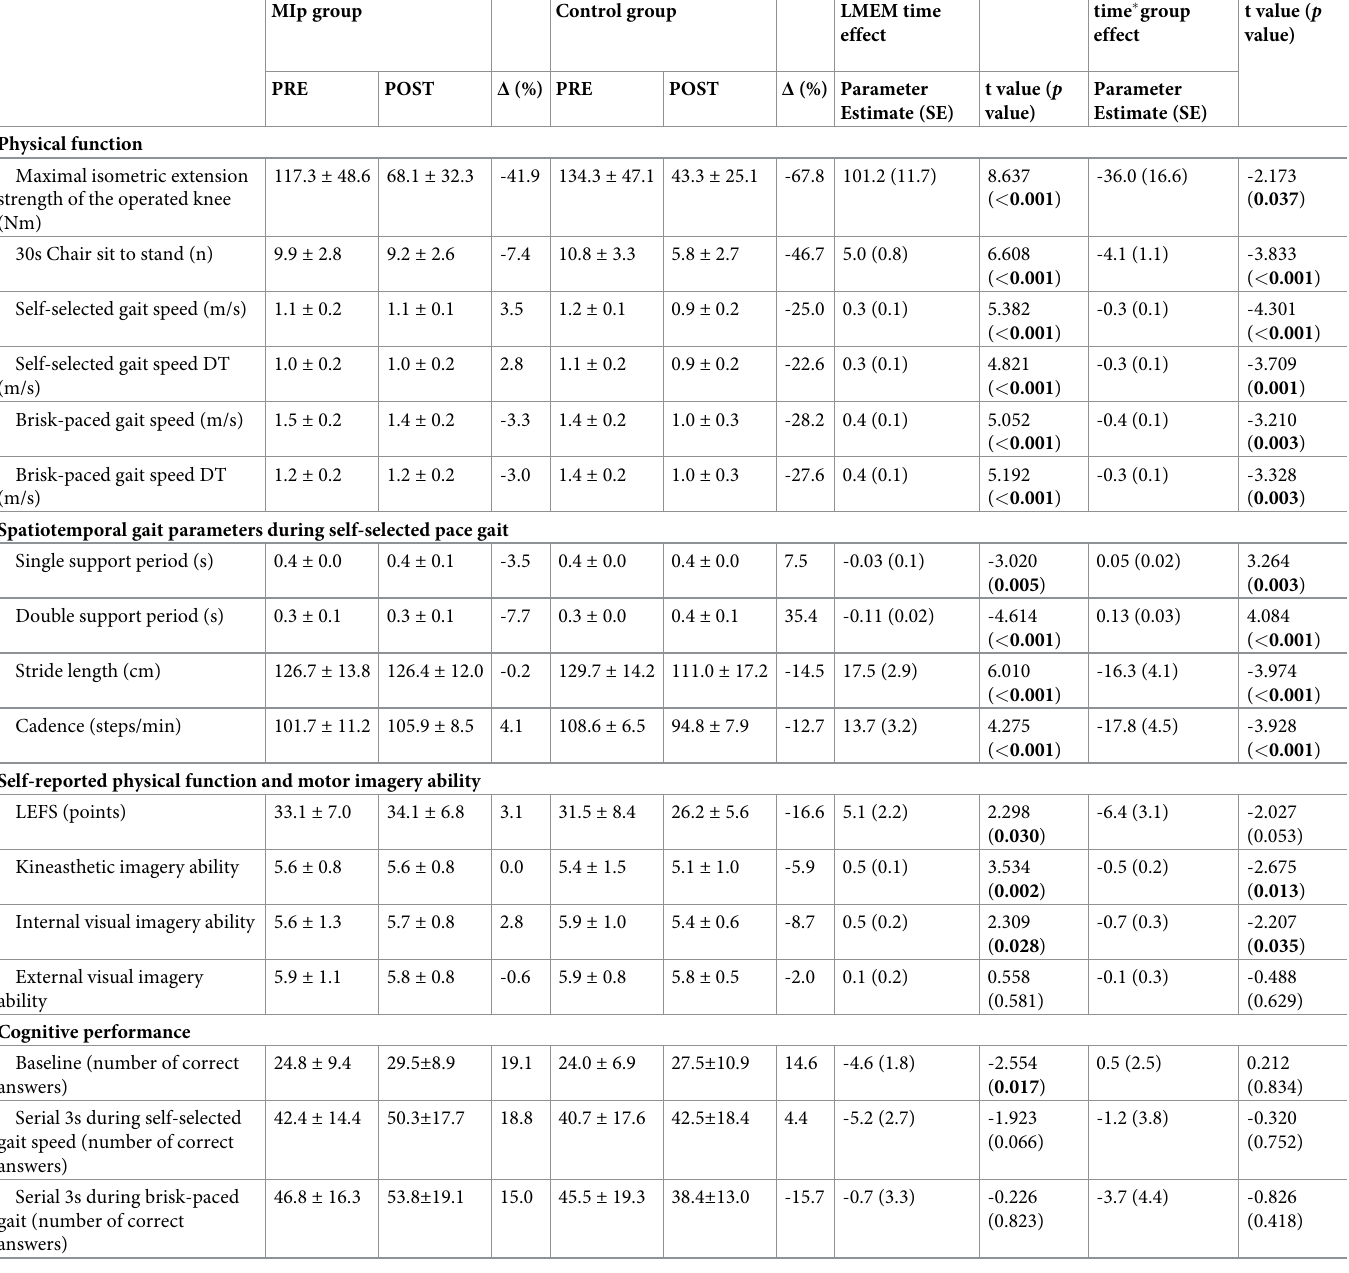
Table 2. Mixed effects models for physical performance and self-reported measures (intention to treat